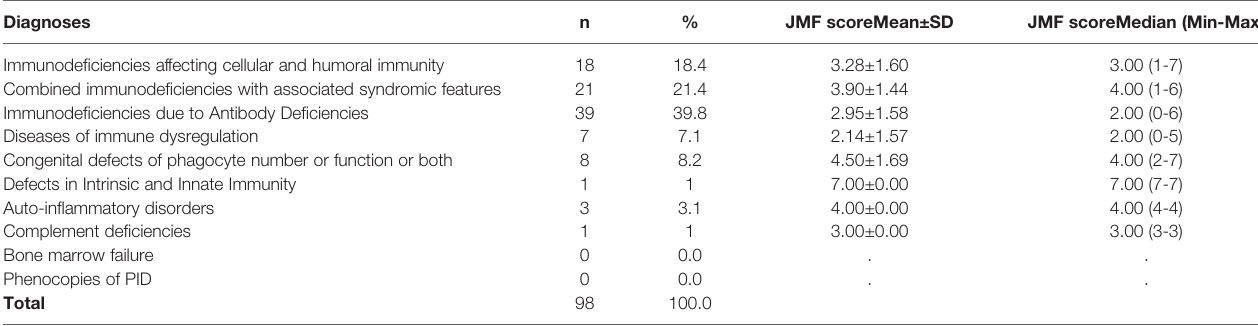
TABLE 2E | IUIS classi fi cation of the patients with PID (2020) and JMF scores of the PID subgroups.